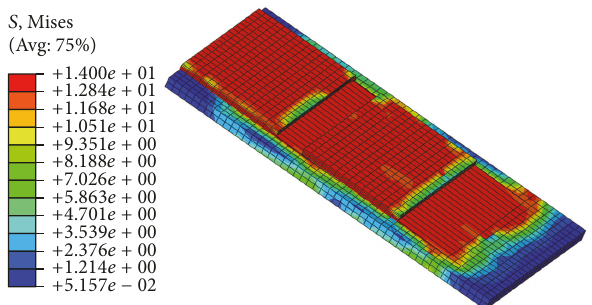
Figure 12: Stress nephogram of displacement 90 mm.